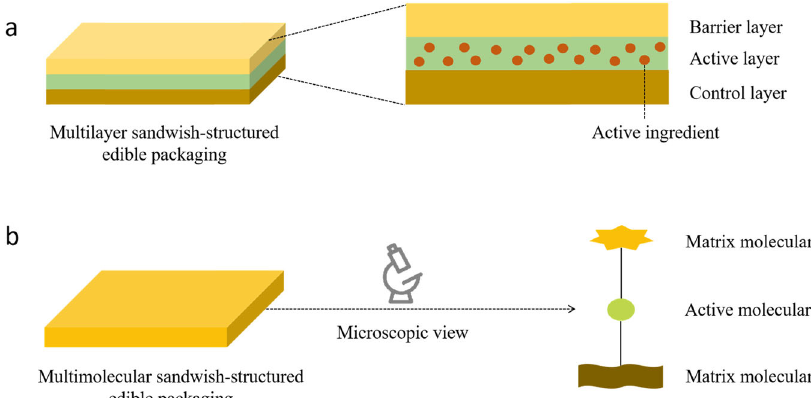
Fig. 1 Schematic representation of biodegradable packaging materials with sandwich structure. a Multilayer and b composite